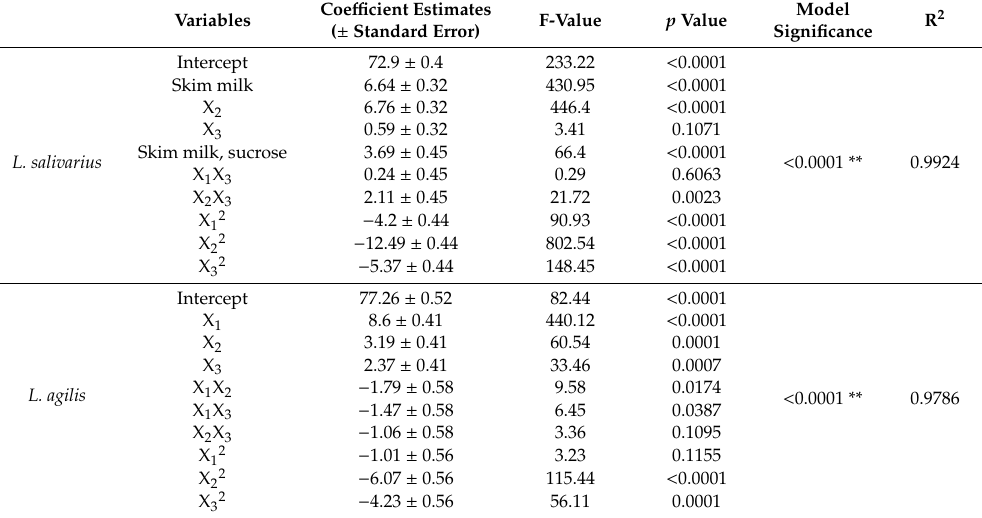
Table 2. Coe ffi cient estimates and ANOVA (Analysis of variance) analysis of the quadratic model for lactobacilli survival during the lyophilization process.